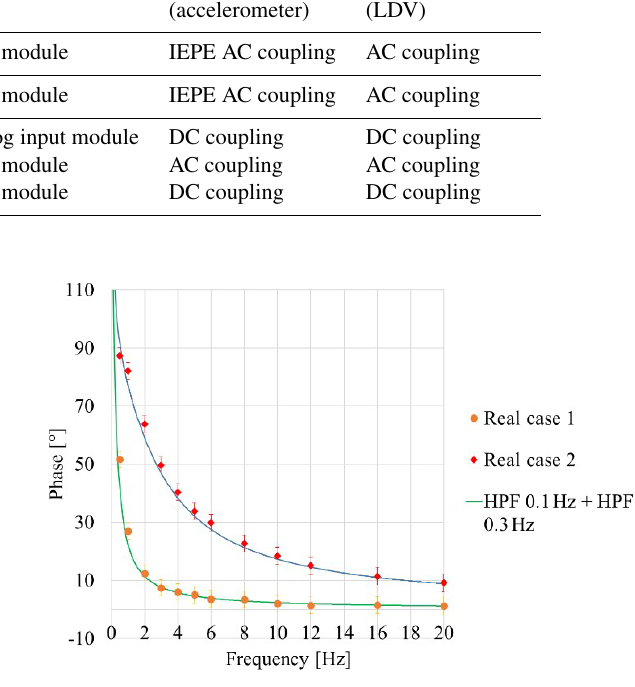
Figure 4. Comparison between theoretical curves modelling two high-pass filters (HPFs) in cascade and experimental